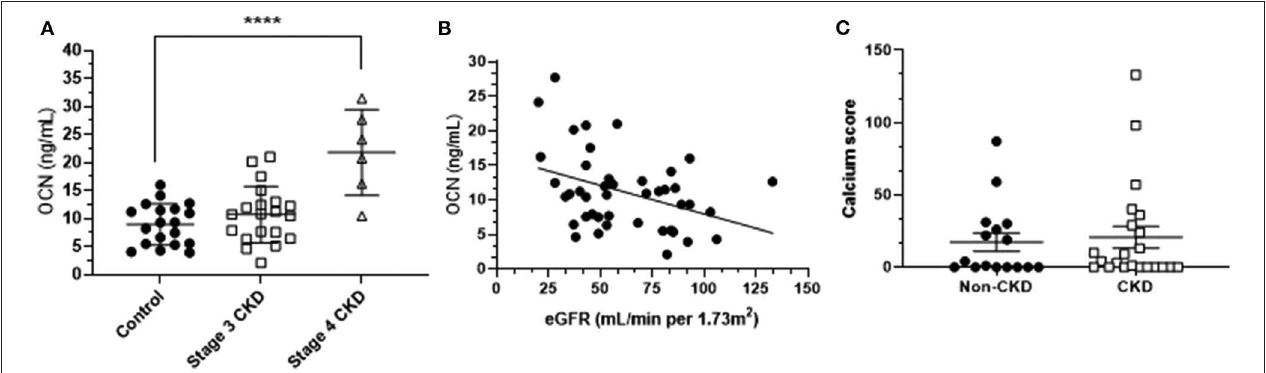
FIGURE 1 | (A) Mean ( ± SD) osteocalcin (OCN) concentrations of stage 3 CKD patients, stage 4 CKD patients and age-matched controls. Differences were assessed by one-way ANOVA. **** indicates p < 0.001. (B) The osteocalcin-eGFR (estimated glomerular filtration rate) relationship, assessed by Spearman’s correlation ( r = − 0.32; p < 0.05). (C) Mean ( ± SD) calcification scores of CKD patients and age-matched